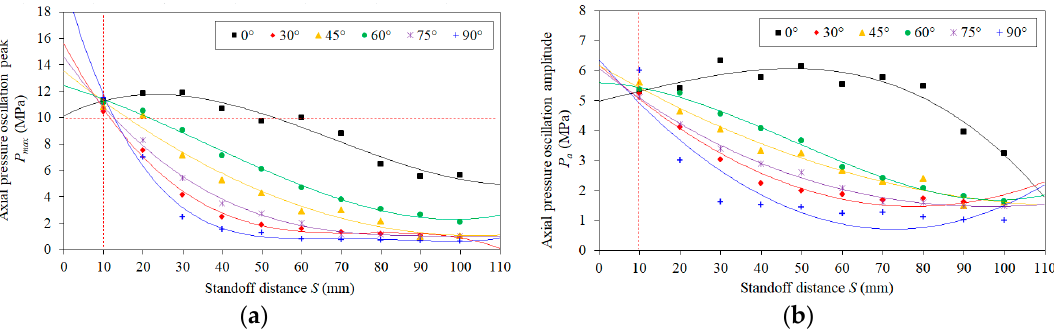
Figure 5. P max ( a ) and P a ( b ) as a function of S at P i = 10 MPa.